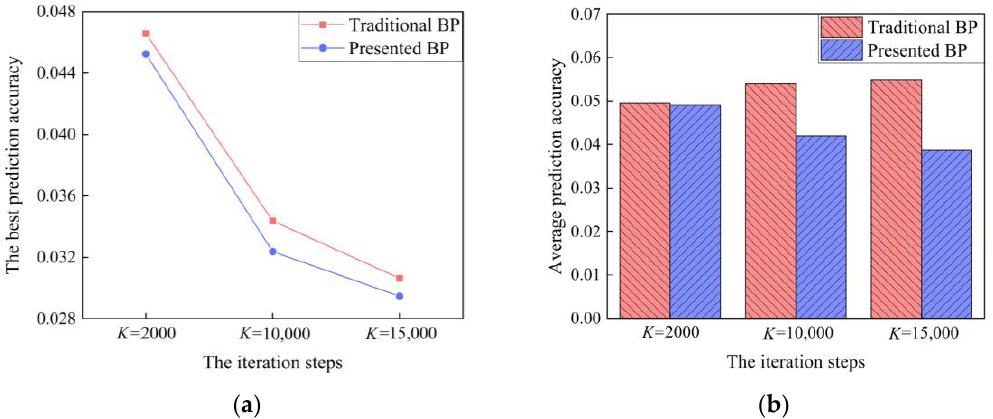
Figure 10. Comparison of the prediction accuracy of the traditional model and the presented model: ( a ) the best prediction accuracy of the models; ( b ) the average prediction accuracy of the models.